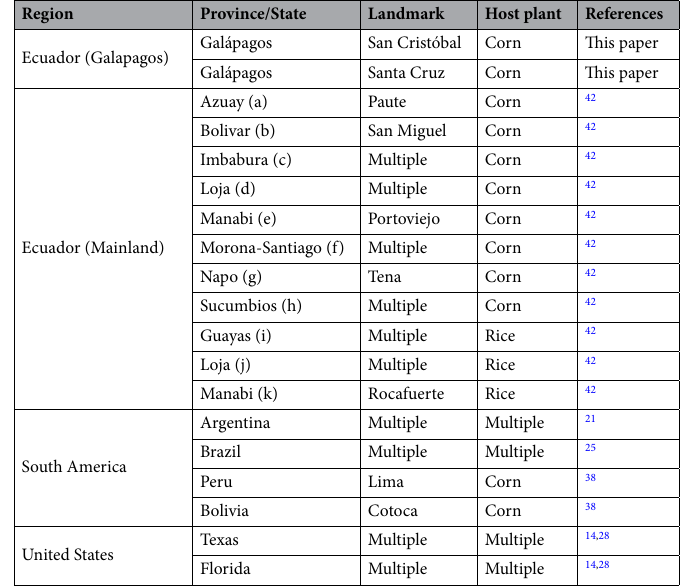
Table 1. Fall armyworm sampling site information for collections described in this study. Letters in parenthesis refer to map locations in Fig.